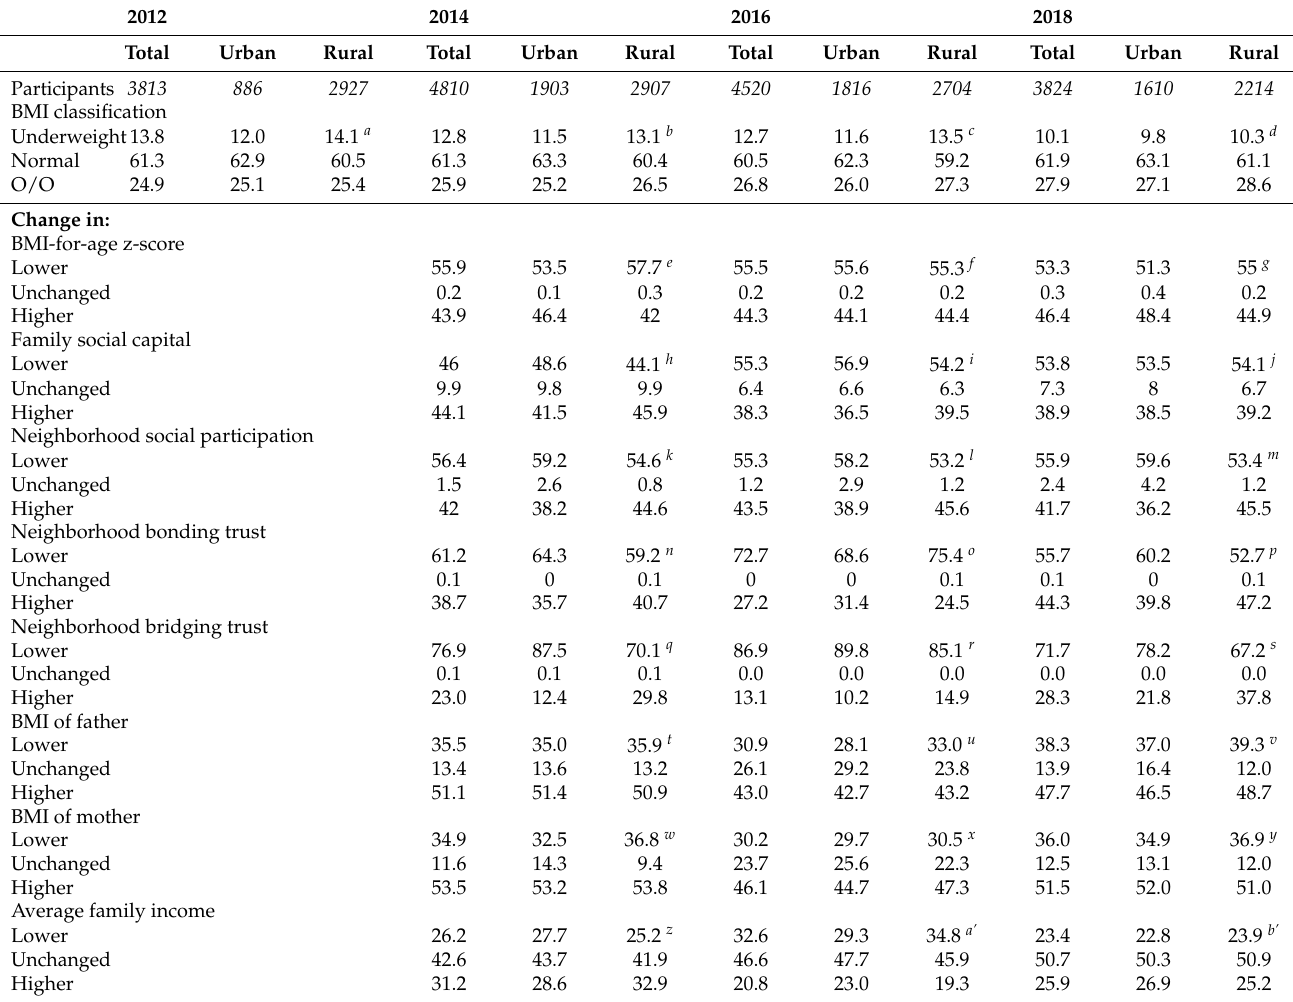
Table 2. Changing descriptive statistics of the total, urban, and rural child participants across survey waves (longitudinal data, N , %